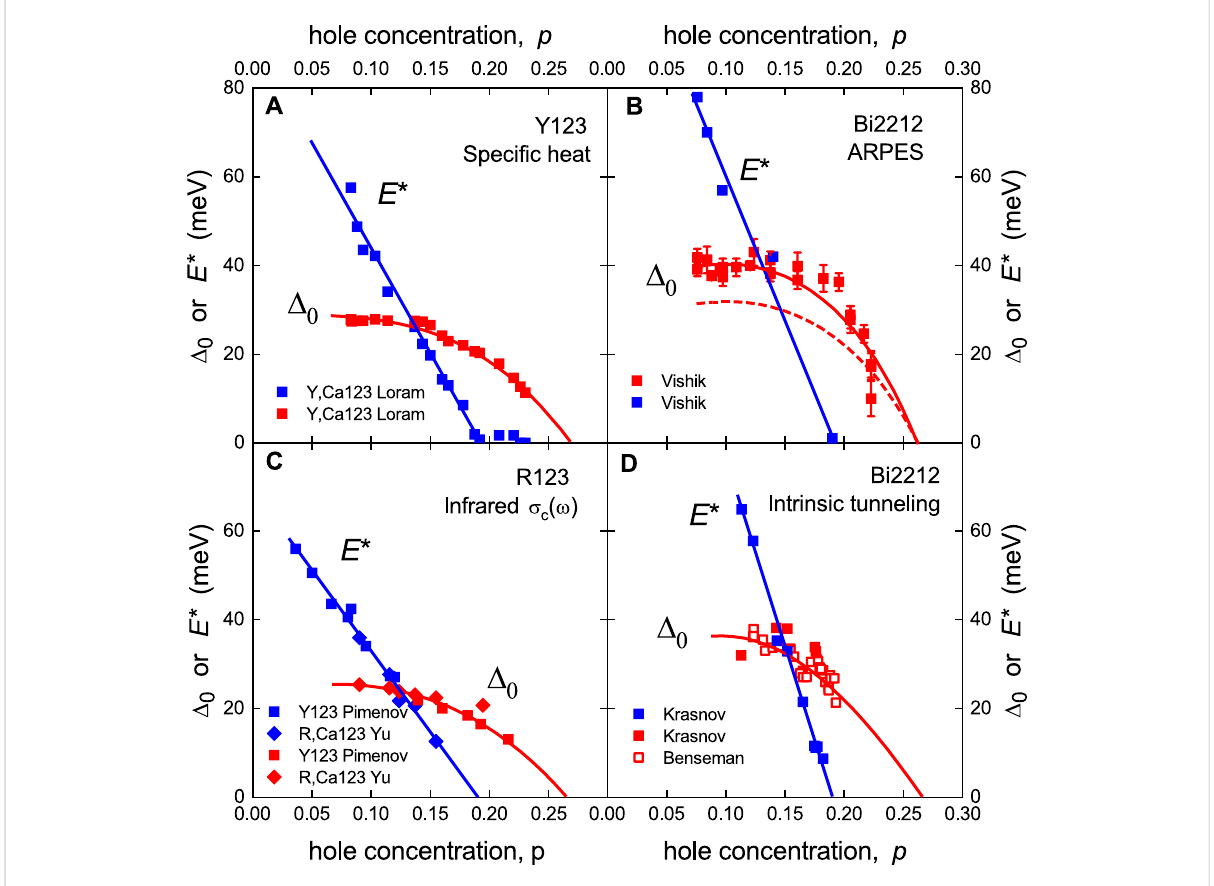
FIGURE 10 Doping-dependent values of Δ 0 ( p ) (red symbols) and E *( p ) (blue symbols) for (A) Y 0.8 Ca 0.2 Ba 2 Cu 3 O 7 − δ derived from our speci fi c heat measurements, (B) forBi2212derivedfromARPESmeasurements[16], (C) forRBa (B) , the red dashed curve represents the line of the Vishik data when we linearly extrapolate the pairing gap to the